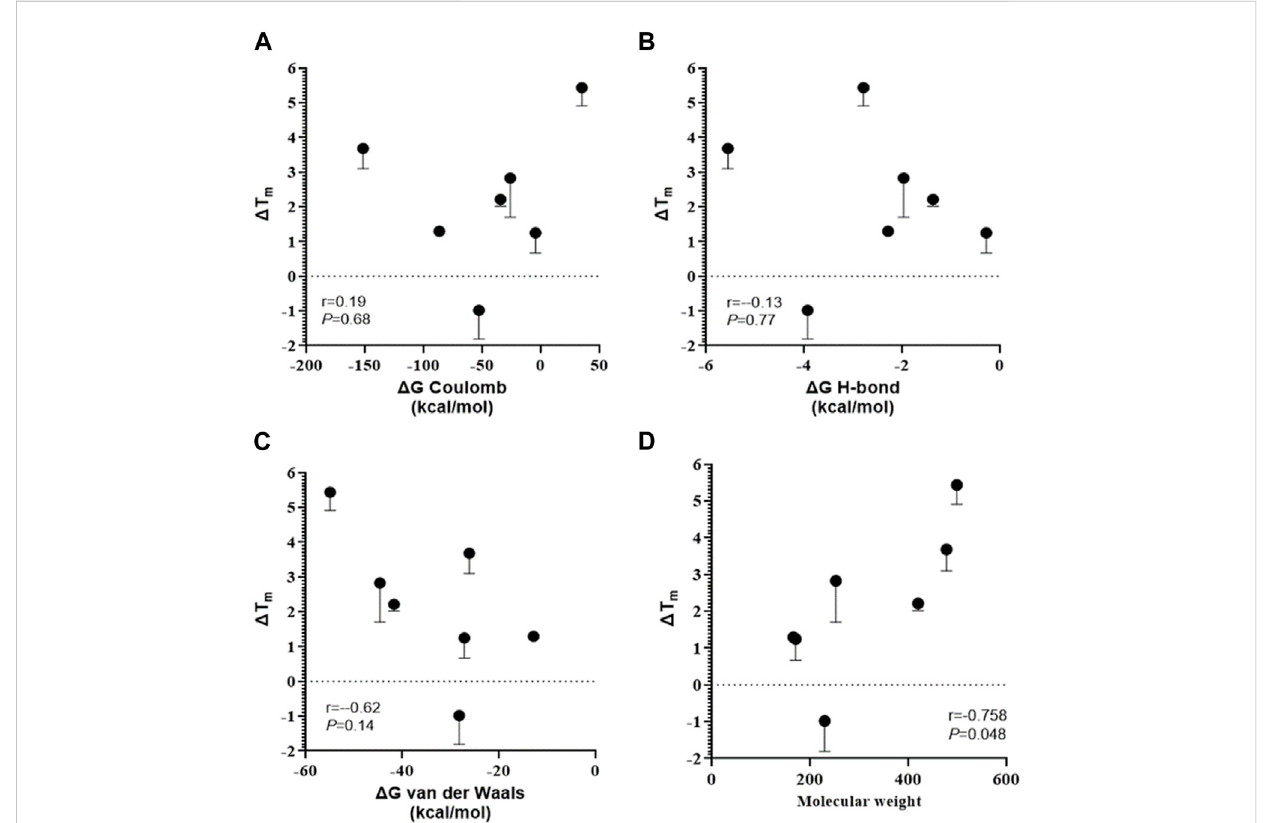
FIGURE 6 Correlation between thermal shift and ligand chemical structure. Thermal shift was calculated as the difference between the melting temperatures in the presence and absence of a ligand ( Δ T m ). Pearson ’ s Rank-Order analyses between the Δ T m and the predicted energy of coulomb (A) , hydrogen- bond (B) , van der Waals interactions (C) or the molecular weight (D)